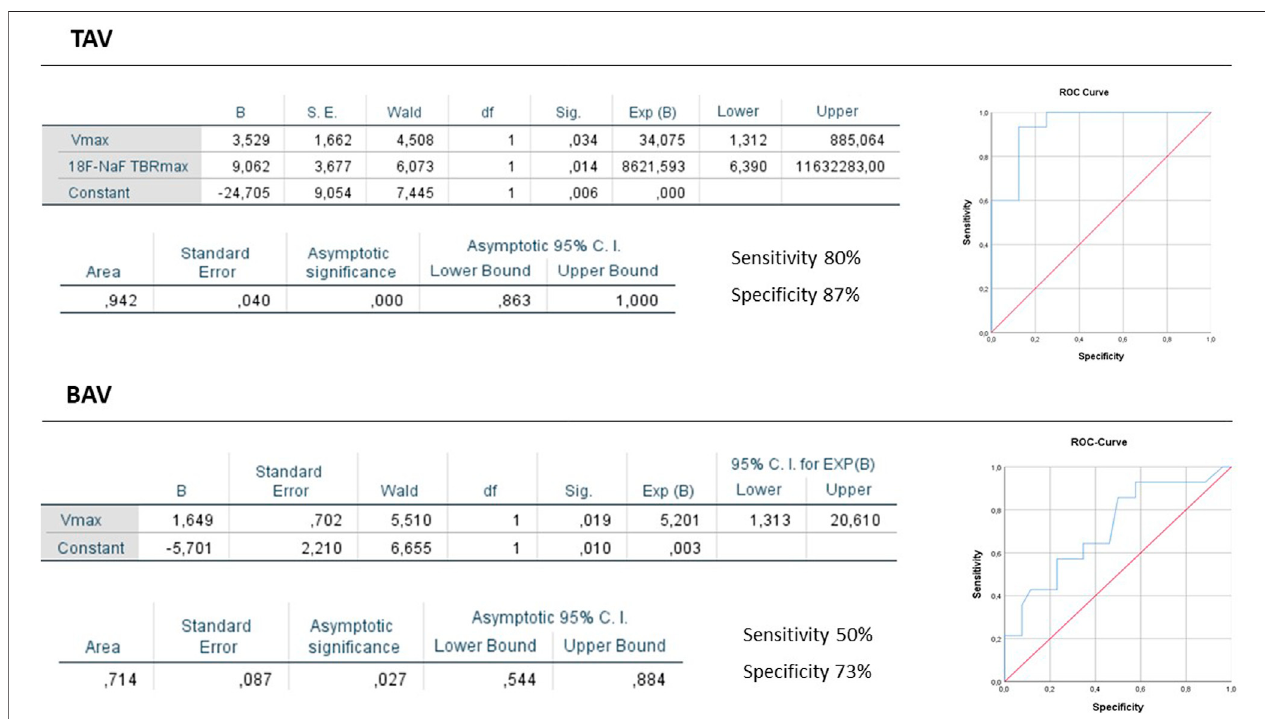
FIGURE 4 | Results of the ROC analysis in all patient and TAV and BAV